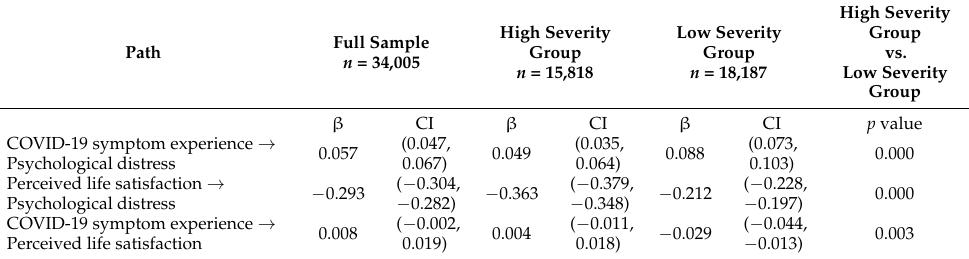
Table 3. Multi-group analysis